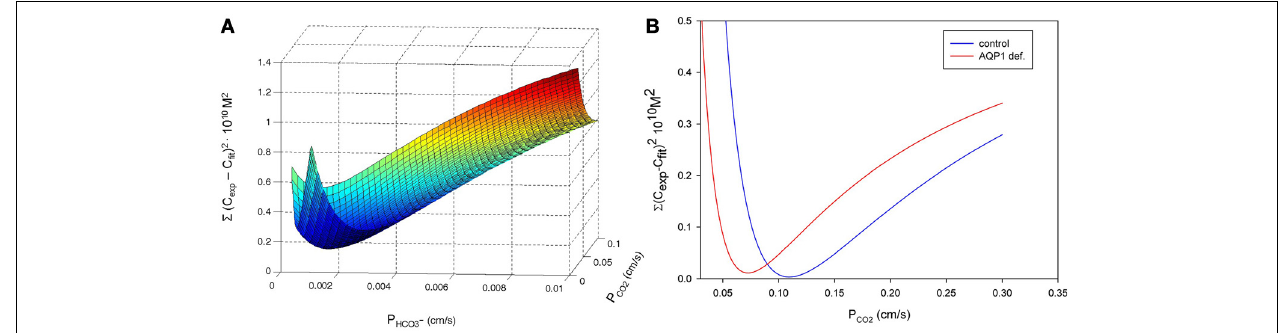
FIGURE 14 | Quality of the fitting procedure, expressed as sum of squared deviations between experimental and calculated concentrations of C 18 O 16 O. (A) Two-dimensional representation illustrating that a unique minimum of the sum of squares defines P CO as well as P HCO − for a given experimental record of C 18 O 16 O decay. 3 There are no local minima whatsoever. Reproduced from Al-Samir et al.